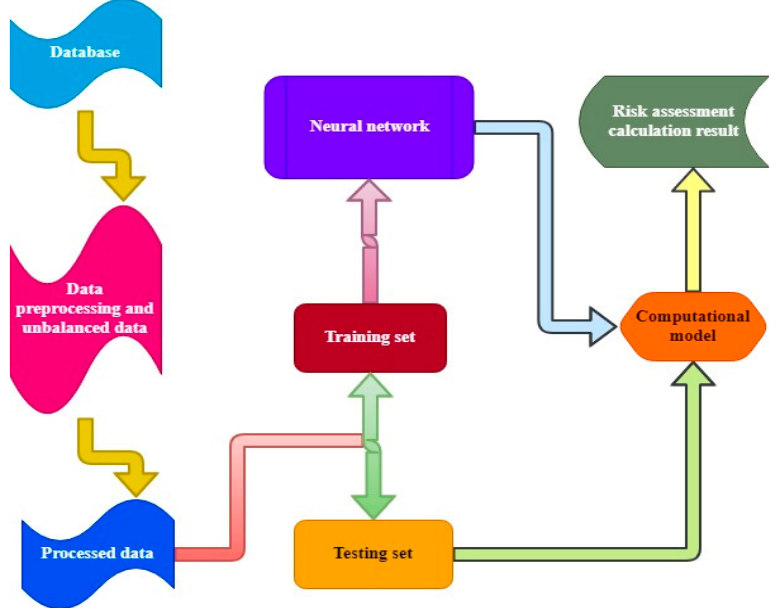
Figure 1. Data balancing model structure and its process.